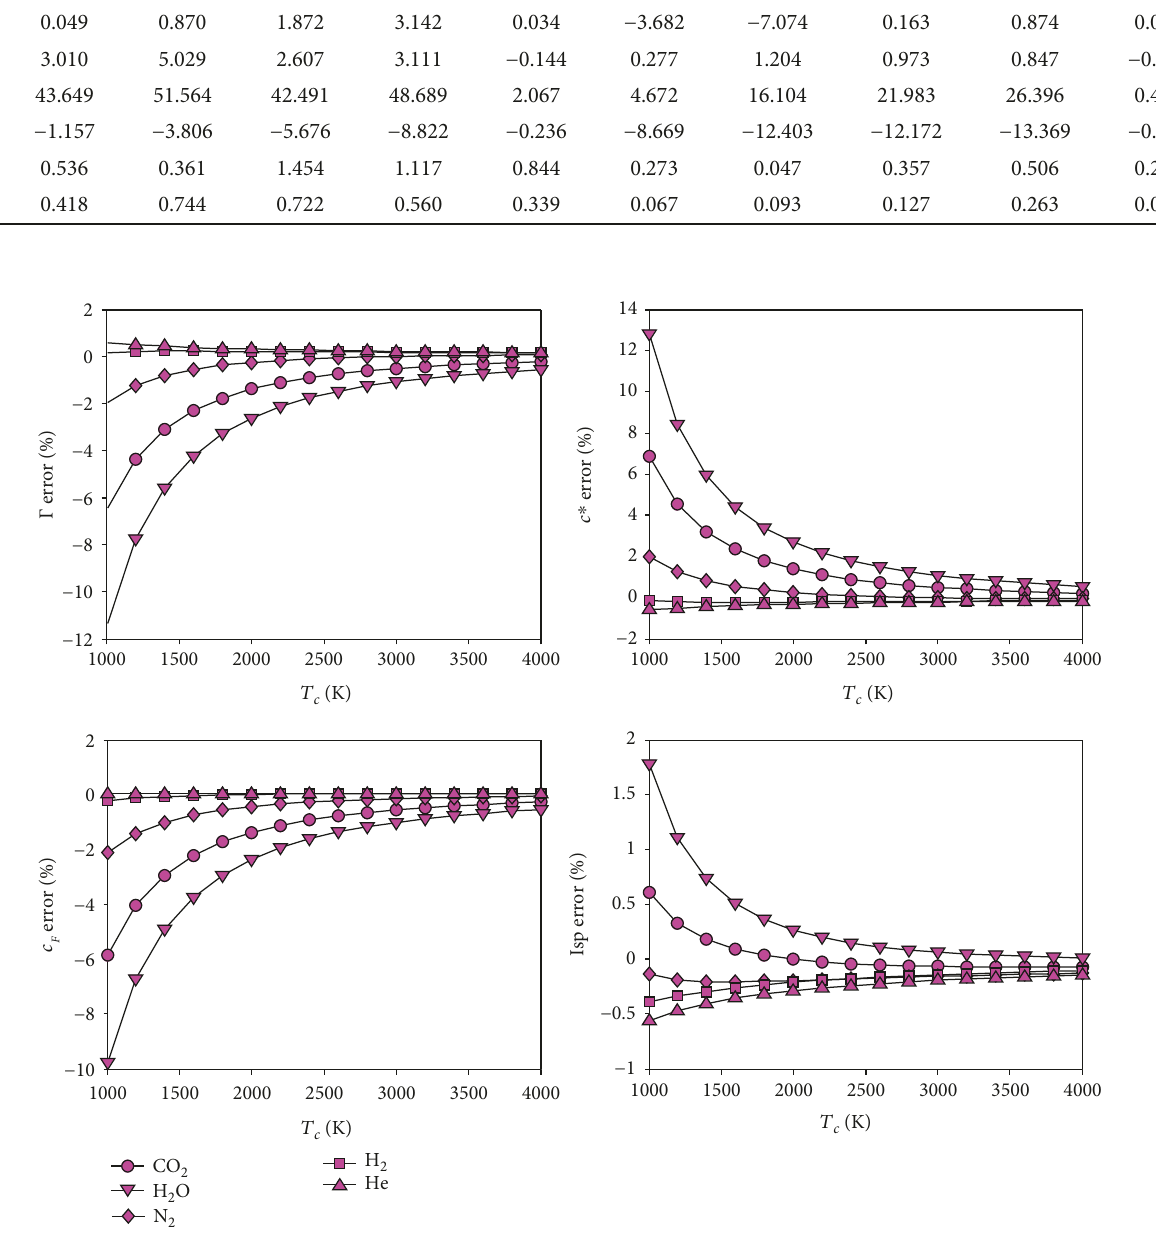
= 10MPa , T = 1000 c c